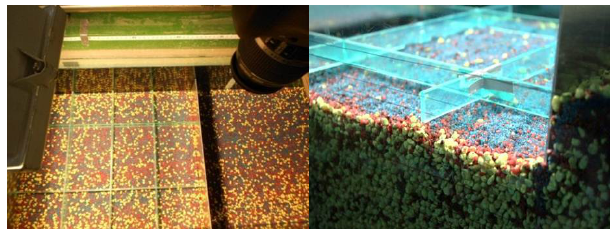
Figure 4. Set-up for image analysis and sampling: top view of the sampling area with the sampling grid placed on the bed surface and the metal sheets inserted into the bed. The Plexiglas r grid and sam- pling per grid cell is only needed for the assessment phase of the image analysis method. Once the conversion method is clear, the sampling grid is no longer required and an entire thin sediment layer can be removed at once without using the grid.